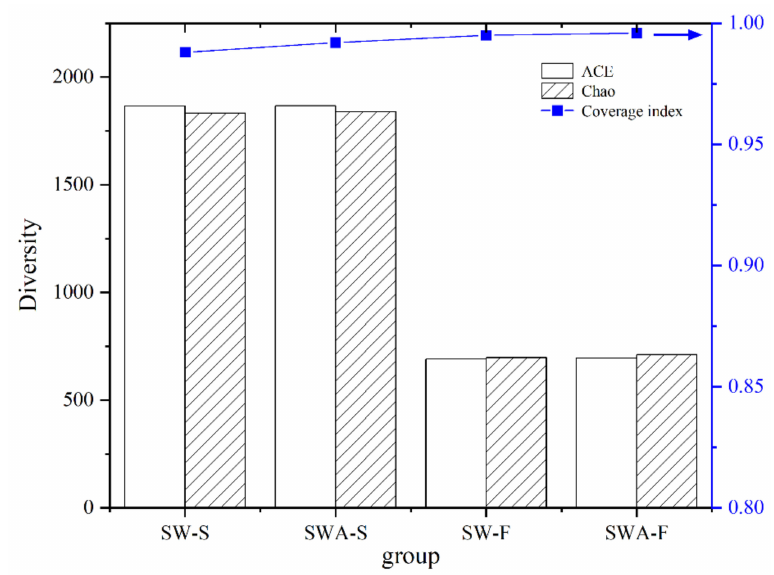
Figure 5. Diversity indices of microbial communities in the black floats and sediments. (SWA-F: black floats in the sediments-water-algae group; SWA-S: sediments in the sediments-water-algae group; SW-S: sediments in the sediments-water group; SW-F: black floats in the sediments-water